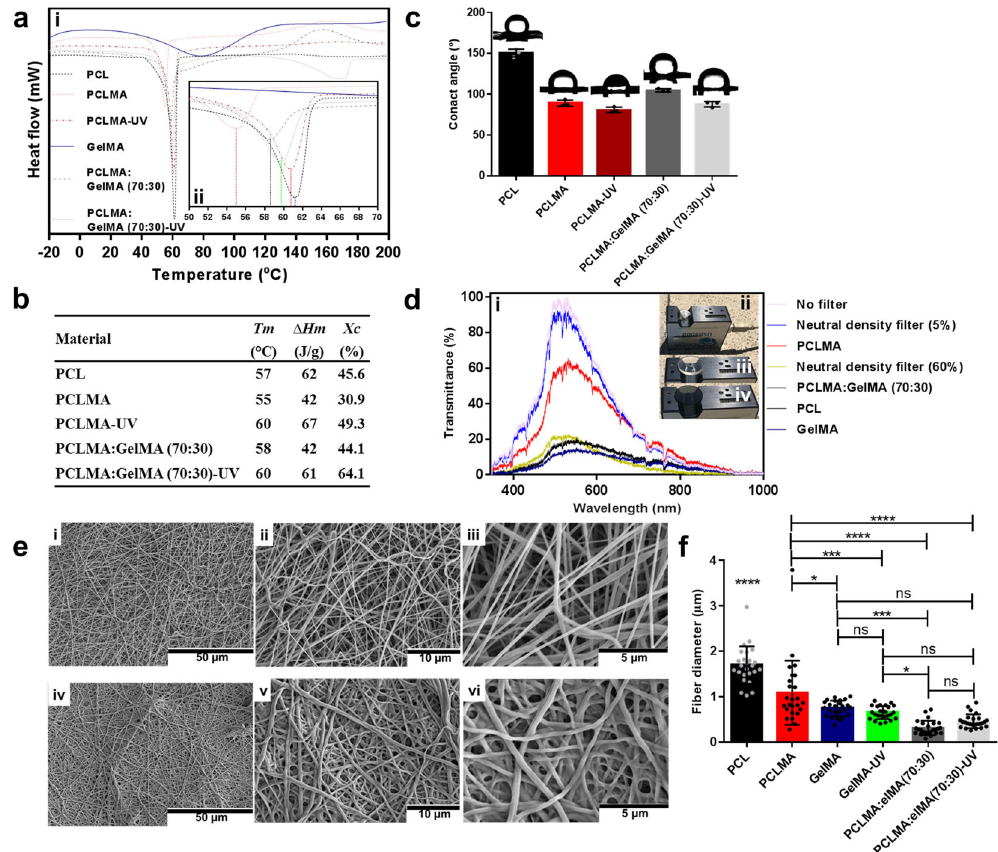
Fig. 4 Thermal, hydrophilicity, transparency, and morphology characterizations. a , i Differential scanning calorimetry (DSC) thermograms of the various fi bers. ii Zoomed area. b The thermal analysis of the fi bers providing the T Δ H fi ber m (crystalline melting temperature), m (melting enthalpy) and X c ( crystallinity). c The contact angles measured and the images of the water drops on the fi bers captured during the analysis. Values are mean ± SD, N = 3. d , i Light transmittance property analysis of the various nano fi bers. ii Demonstrating the setup applying the transparent PCLMA fi ber, iii neutral density fi lter 5% and iv neutral density fi lter 60% of absorbance. e Characterization of the morphology of the electrospun nano fi bers through scanning electron microscopy (SEM) analysis with various magni fi cations of i – iii, PCLMA:GelMA (70:30) and the iv – v PCLMA:GelMA (70:30)-UV. f The fi ber diameter for PCL, PCLMA, GelMA, GelMA-UV, PCLMA:GelMA (70:30), and PCLMA:GelMA (70:30)-UV. Values are mean ± SD, N = 25. ANOVA ( p < 0.05) followed by a Tukey ’ s multiple comparisons test. * p < 0.05, *** p < 0.005, **** p < 0.001, ns not signi fi cant, mean statistical